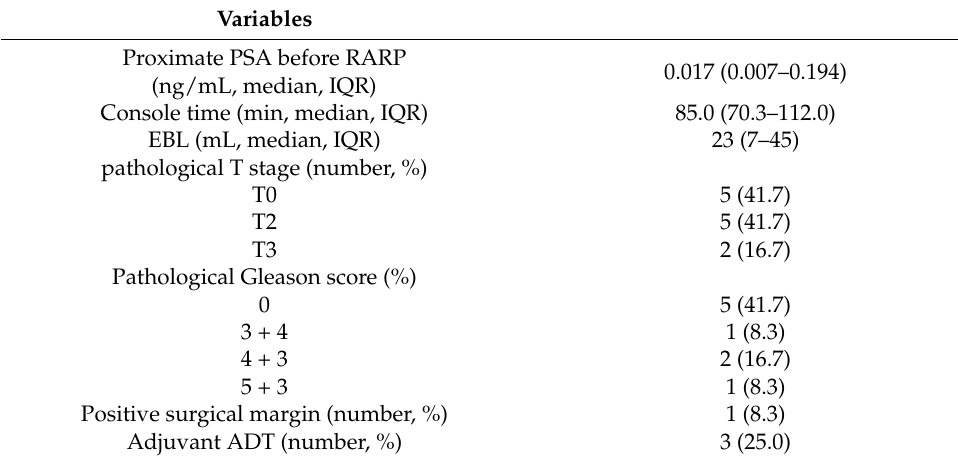
Table 2. Surgical and pathological outcomes.